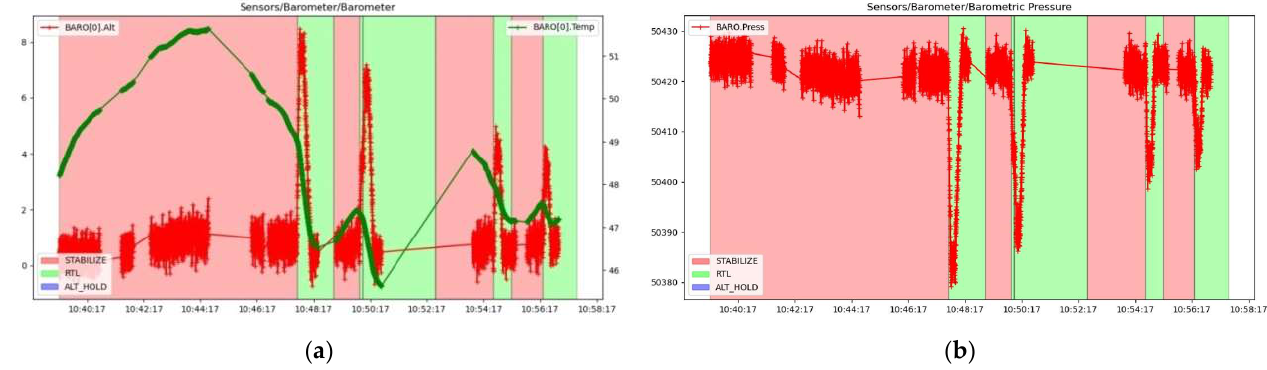
Figure 26. Hexacopter measured parameters. ( a ) Altitude and ambient temperature; ( b) Ambient atmospheric pressure.